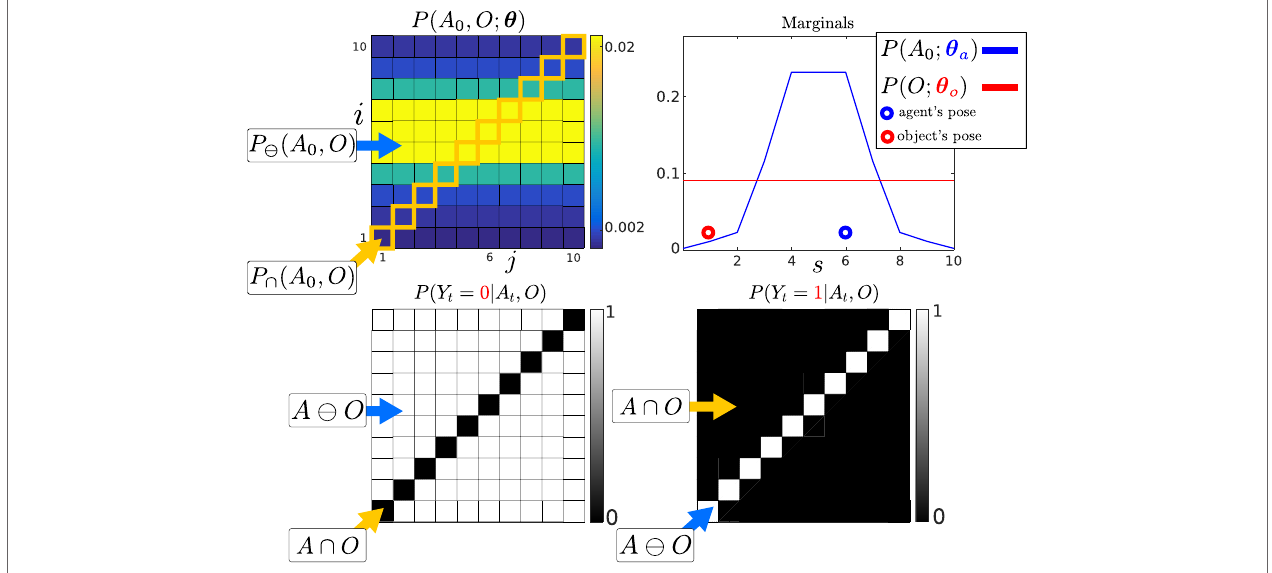
FIGURE 4 | Top : Left: Initialization of the agent and object joint distribution. Right: Marginals of the agent and object parameterized by (cid:18) a and (cid:18) o , giving the probability of their location. The marginal of each random variable is obtained from equation (4). The probability of the agent and object being in state s = 6 is given by summing the blue and red highlighted parameters in the joint distribution. Bottom : 1D world Likelihood P ( Y t | A t , O ), the white regions A ∩ O will leave the joint distribution unchanged while the black regions will evaluate the joint distribution to zero. Left: No contact detected with the object, the current measurement is Y t = 0, both the agent and object cannot be in the same state. Right: The agent entered into contact with the object and received a haptic feedback Y t = 1. The agent receives only two measurement possibilities, contact or no contact.